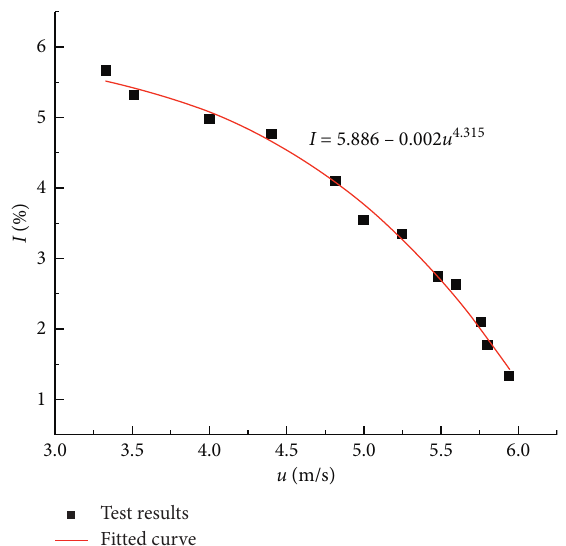
Figure 3: Fitting curve of the turbulence intensity and wind velocity.